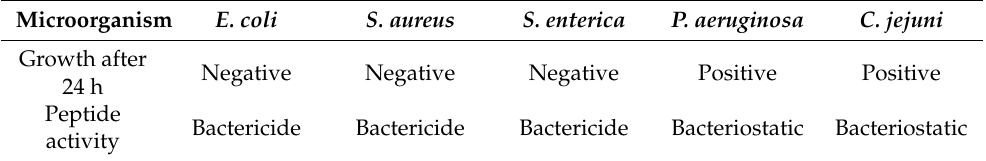
Table 7. In vitro test for the detection of the growth of microorganisms after 18 h in the presence of the synthetic peptide at its higher value of the MIC concentration obtained for the microorgan- isms Escherichia coli (CECT 434), Staphylococcus aureus (CECT 794), Salmonella enterica (CECT 456), Pseudomonas aeruginosa (CECT 108), and Campylobacter jejuni (CECT 9112). Microorganism E. coli S. aureus S. enterica P. aeruginosa C. jejuni Growth after Negative Negative Negative Positive Positive 24 h Peptide Bactericide Bactericide Bactericide Bacteriostatic activity